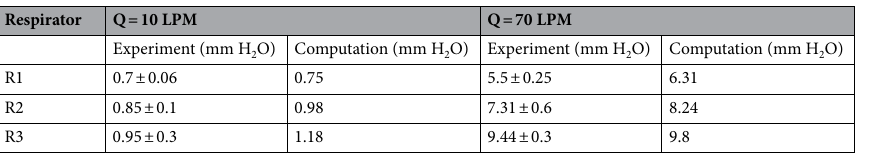
Table 1. Comparison of pressure drop across the flat